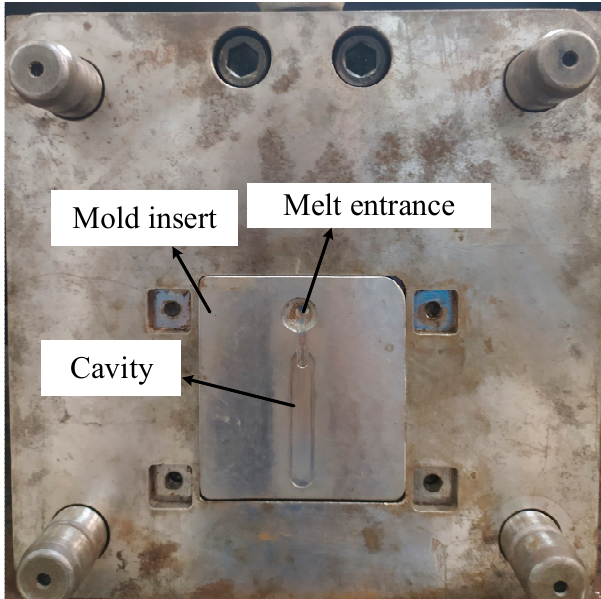
Figure 7. The mold for the melt flow length testing with the gate heating area. Table 2. The molding parameters for the product of the front cover plate. Molding